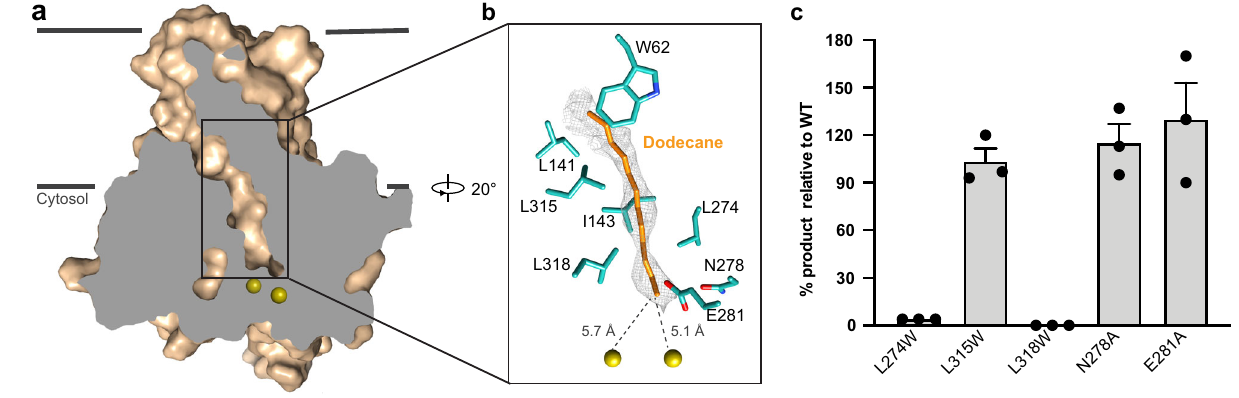
Fig. 3 | Substrate channel of FtAlkB. a A slice view of the substrate channel of FtAlkB.Twoiron atoms are shown asolive spheres. b A close-up view of the ligand density fi tted with dodecane. Key cavity residues are shown in sticks. c Alkane